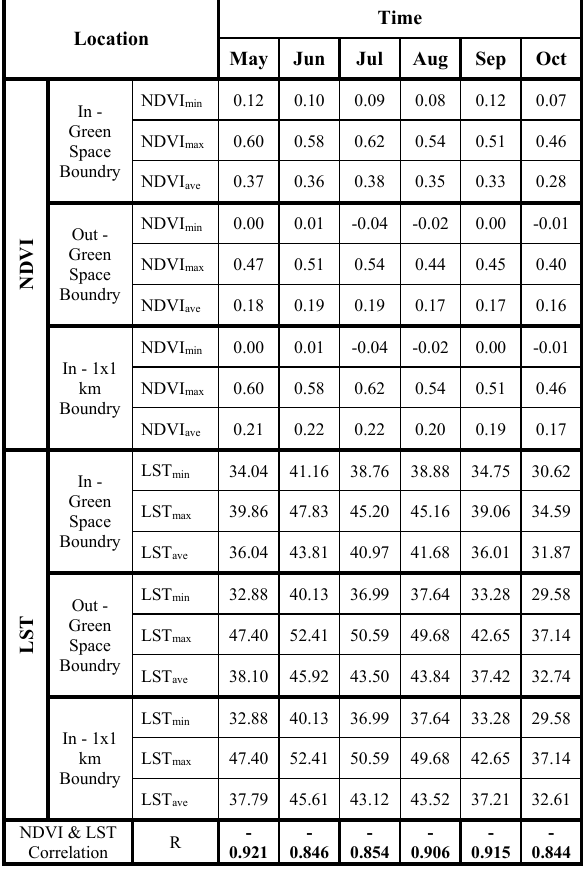
Table 2. The correlation between the values of NDVI and LST with the NDVI and LST values of the Akdeniz Kent Park and the surrounding Fairground